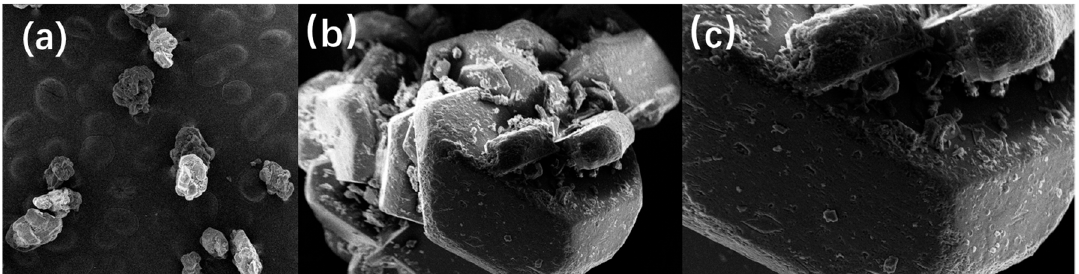
Figure 3. Electron microscopy of DNTF grain morphology: ( a )50 times; ( b ) 500 times; ( c ) 1000 times.